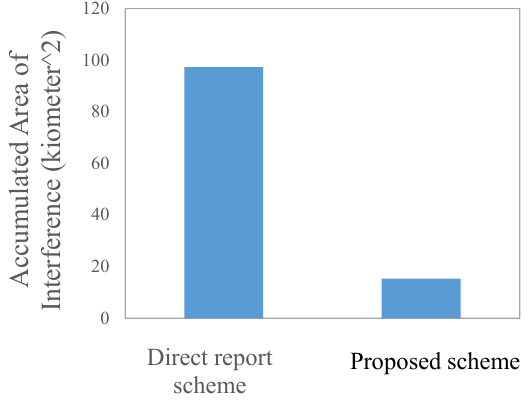
Figure 10. Average resource consumption in Scenario 2.